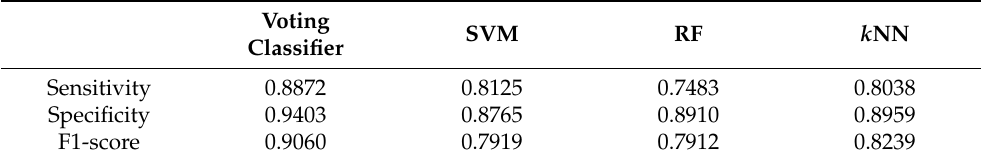
Table 2. The identification metrics of AI-assisted THz